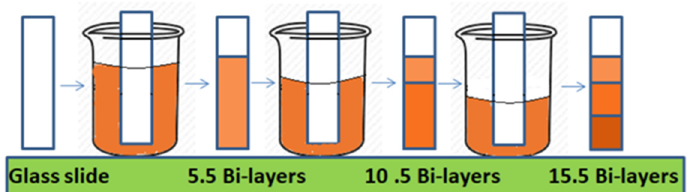
Figure 3. Schematic representation of fabrication of thin film gradients using layer by layer technique.